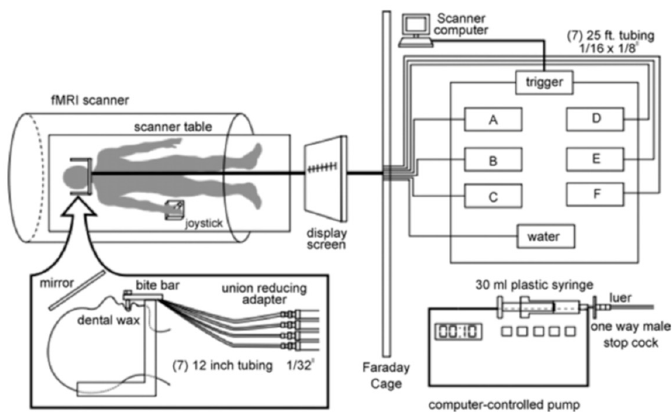
Figure 1. Stimulus delivery paradigm. Reprinted with permission from Haase et al. (2007) [23].